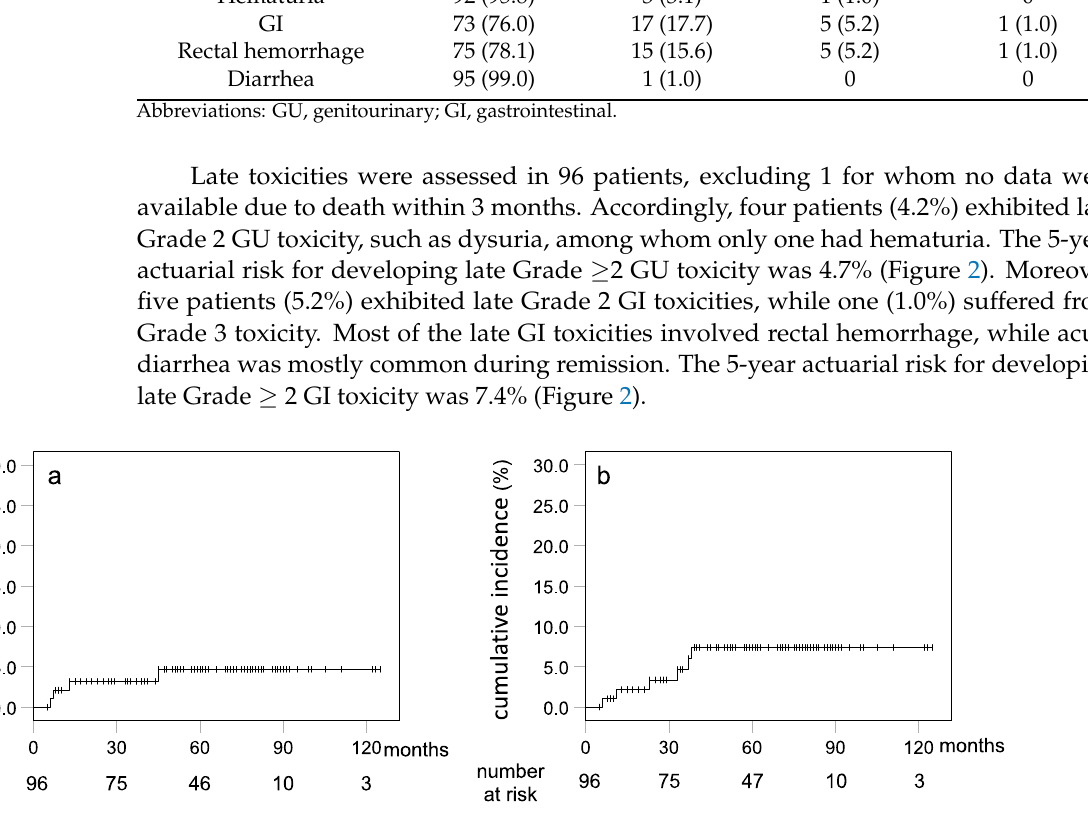
Figure 2. ( a ) Cumulative incidence of Grade ≥ 2 genito-urinary toxicity; ( b ) cumulative incidence of Grade ≥ 2 gastrointestinal toxicity.